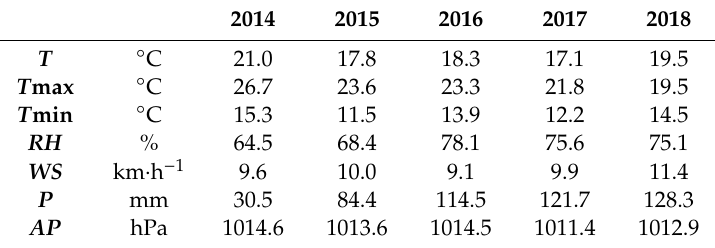
Figure 1. The location of sample collection sites. Table 1. Meteorological conditions at the sampling points of the region in July.